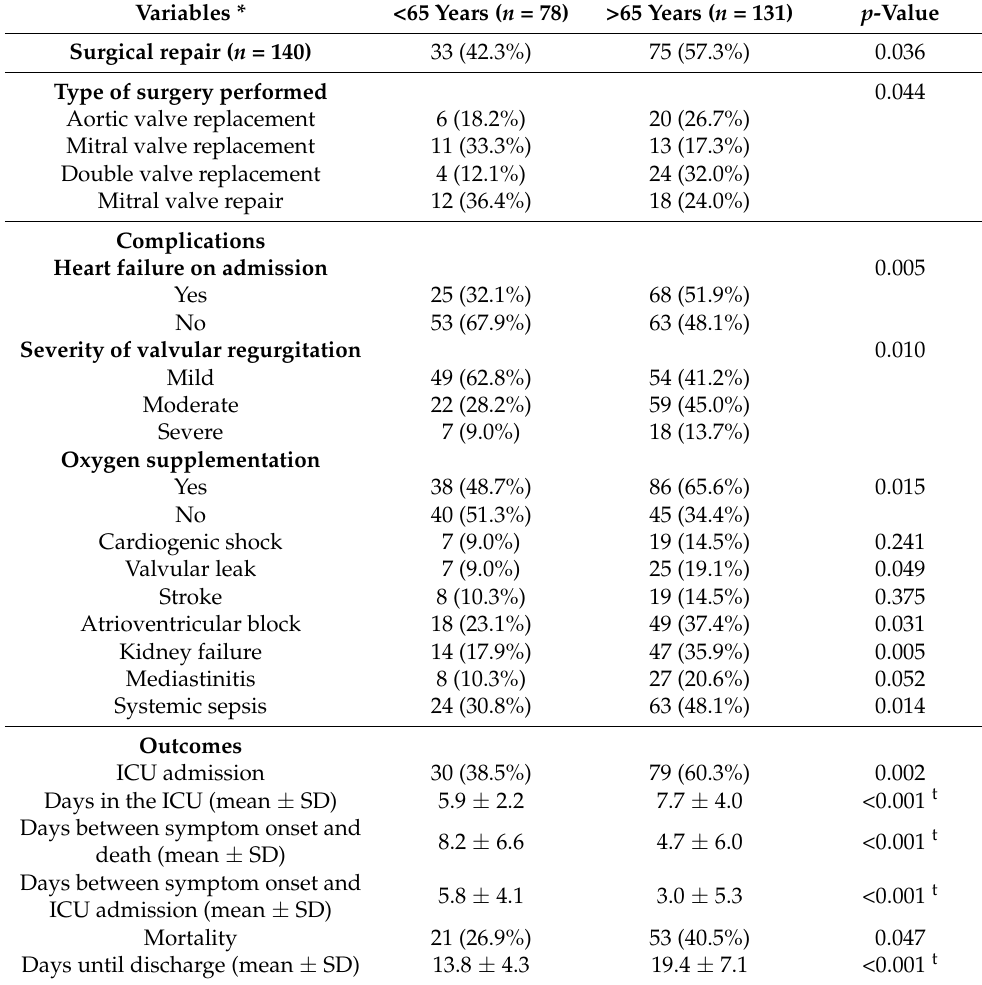
Table 3. Procedures, complications, and